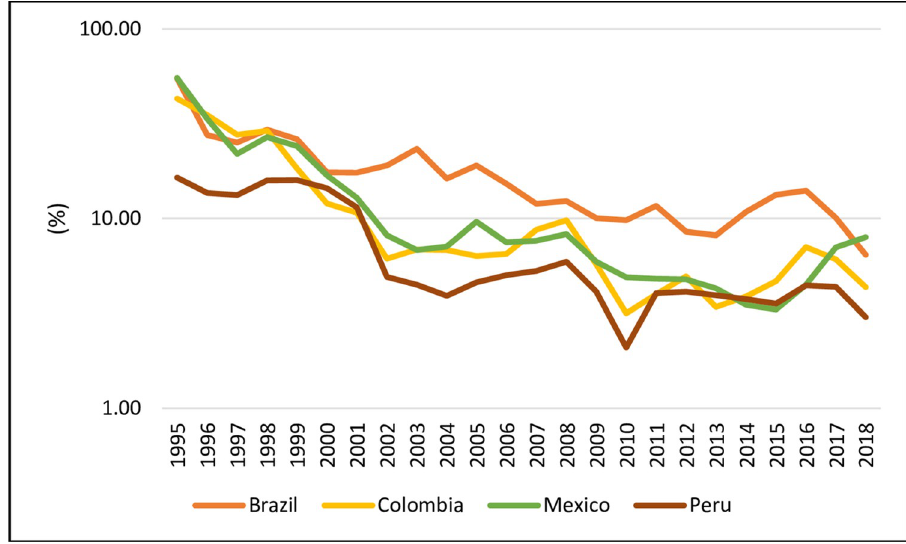
Fig 5. Nominal Interest rates, yearly (1995–2018). Source : Banco Central do Brasil (2020); Banco de la Republica Colombiana (2020); Banco de Me´xico (2020); Banco Central de Reserva de Peru´